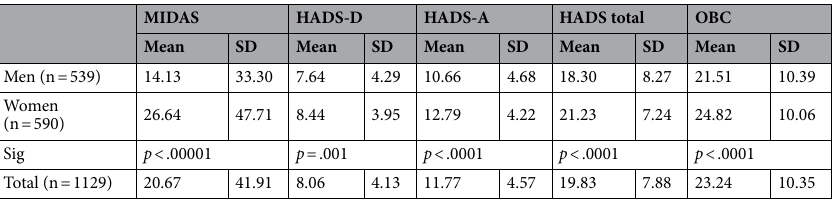
Table 1. Mean scores for the MIDAS, HADS-D, HADS-A, HADS total and OBC in men and women (SD – standard deviation). SD—standard deviation, MIDAS—Migraine Disability Assessment, HADS—Hospital Anxiety and Depression Scale, OBC—Oral Behaviors Checklist, sig.— p -value for the statistical significance of the analyzed differences (see main text for